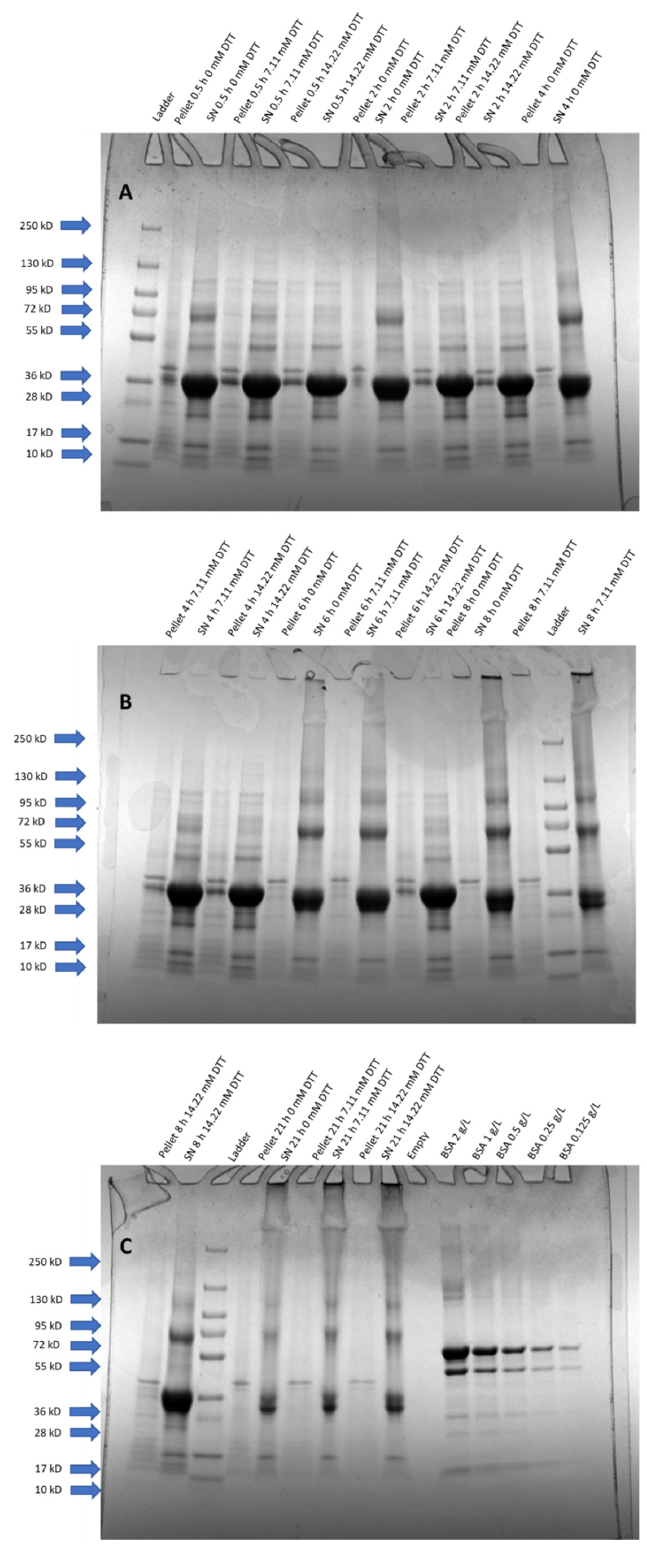
Figure 2. SDS-PAGE analysis of HRP solubilizates with varying DTT concentrations and time factors as depicted in Table 2; non-glycosylated HRP is visible at 34 kDa. The potential dimer formed due to the intermolecular disulfide bridge formation can be seen at 68 kDa. The samples are displayed in the following order from ( A – C ): pellet and supernatant (SN) for each time-point varying the three altered DTT concentrations. Additionally to samples, in ( C ), a standard protein calibration with BSA was performed. Protein ladders were added to confirm protein